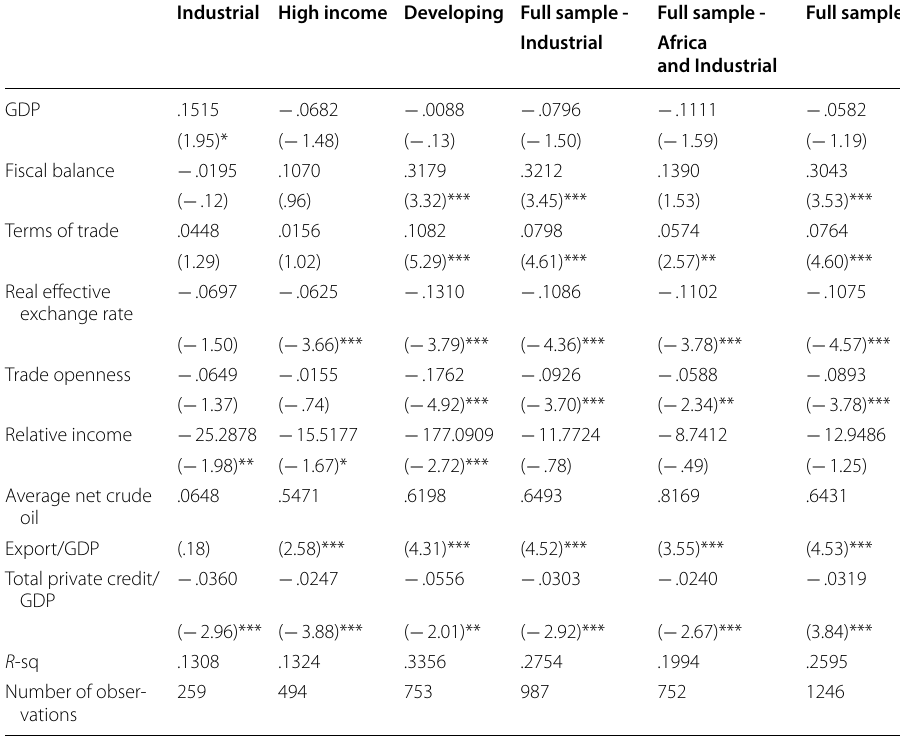
All variables are used in their first differences. t-statistics in parenthesis. *, **, *** indicate significance at 10%, 5%, 1%, respectively. The estimates for the constants are not